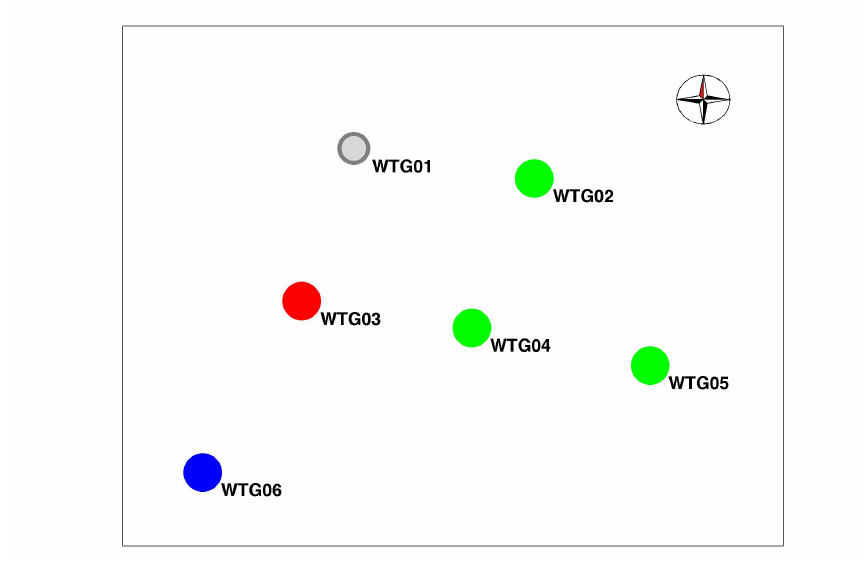
Figure 1. The layout of the wind farm. The healthy wind turbines are indicated in green, the damaged in red, and the recovered in